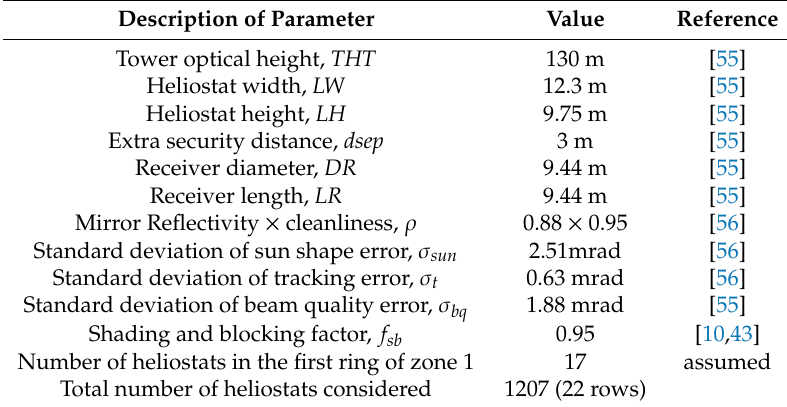
Table 2. Design parameters of heliostat field and solar central